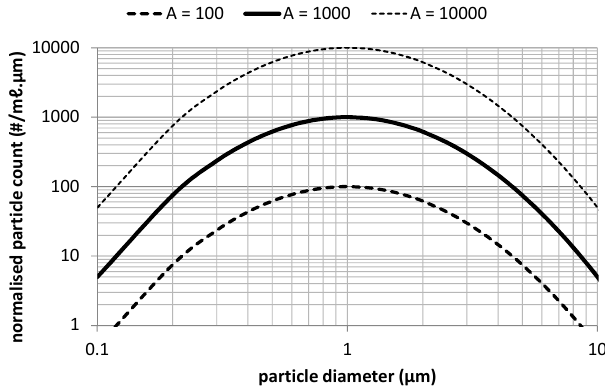
Figure 4. The e ff ect of model parameter A on the particle size dis- tribution, with β = − 1 and C = 0.